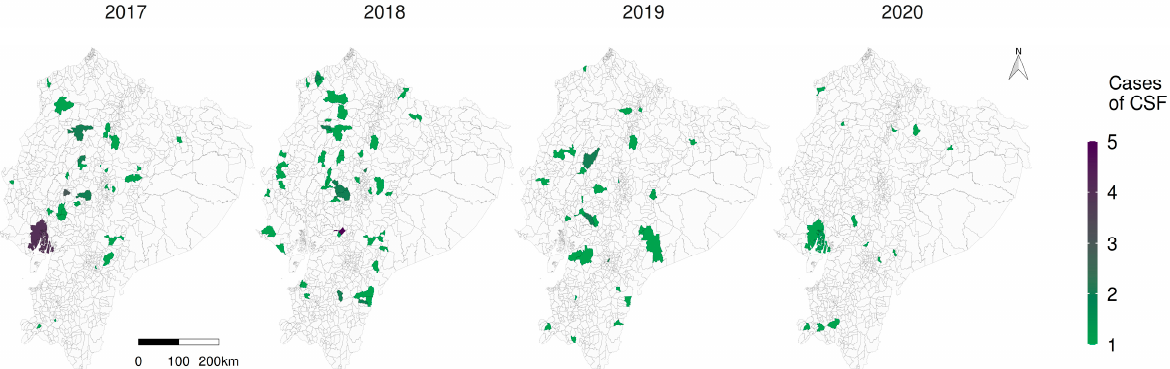
Figure 4. Representation of the number of observed CSF cases (number of positive premises) in Ecuador grouped by parish from 2017 to 2020.